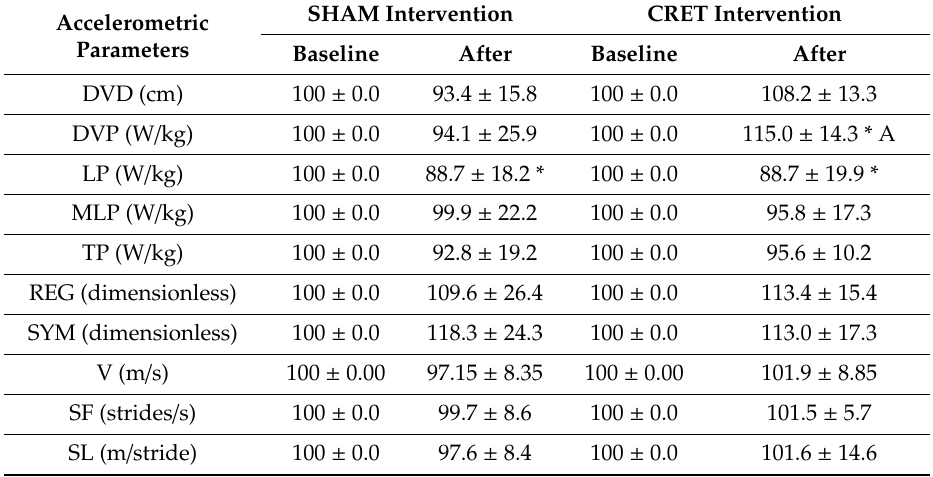
Table 5. Mean values of the accelerometric parameters measured at walk and with the accelerometer fixed in the sacrum midline, before and after the intervention (SHAM group and capacitive resistive electric transfer therapy group (CRET)). Data are expressed as the mean percentage ± SD, relative to baseline values.